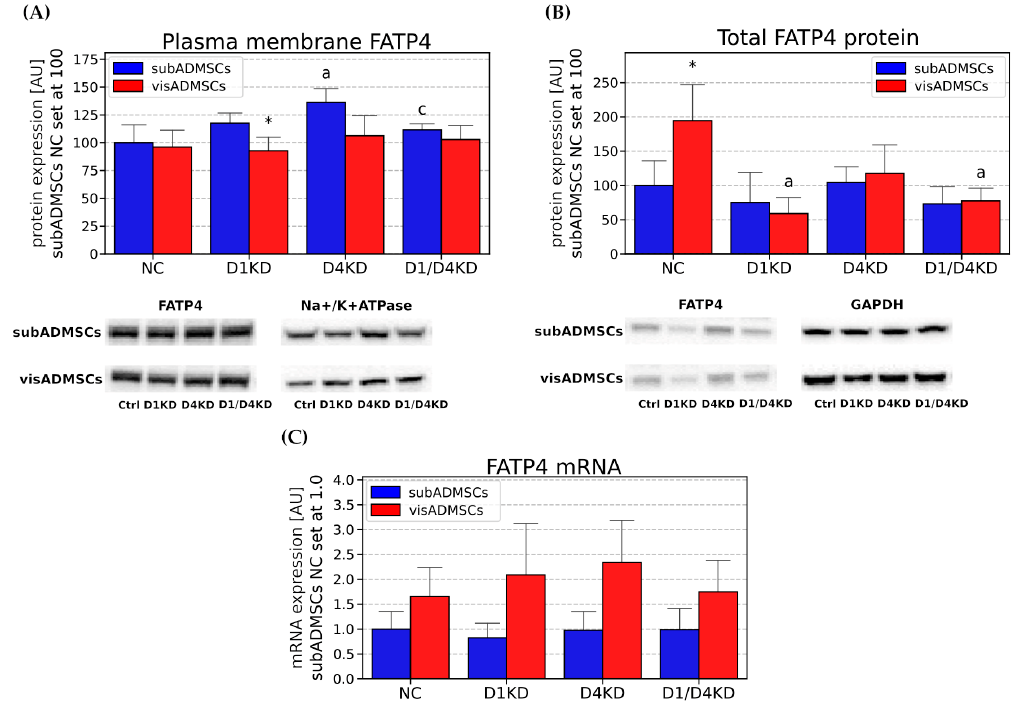
Figure 9. Plasma membrane ( A ), total protein ( B ) and mRNA ( C ) content of FATP4 in TBC1D1- and/or TBC1D4-deficient adipocytes. Bars and whiskers represent the mean and SD respectively. Number of patients equals four (measurements taken in duplicate). Values are expressed in arbitrary units; the mean in subADMSCs' negative control was set at 100. Representative Western blot images are shown. a—difference versus NC ( p < 0.05); b—difference versus D1KD ( p < 0.05); c—difference versus D4KD ( p < 0.05); * p < 0.05 significantly different from visADMSCs. Designation of the groups: NC— negative control containing non-targeting siRNA fragment; D1KD—knockdown of TBC1D1 ; D4KD—knockdown of